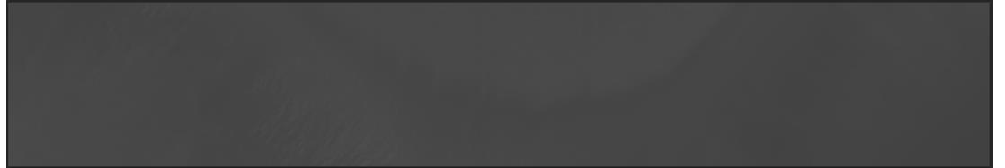
Figure 16. The image with the maximum compression ratio (smooth Yangtze River).